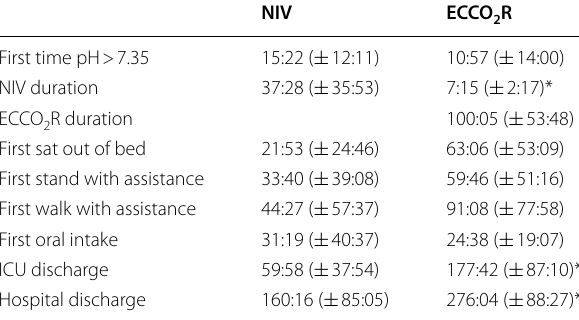
Mean ( SD) time is presented in the format hours:minutes (* p < 0.05) ±